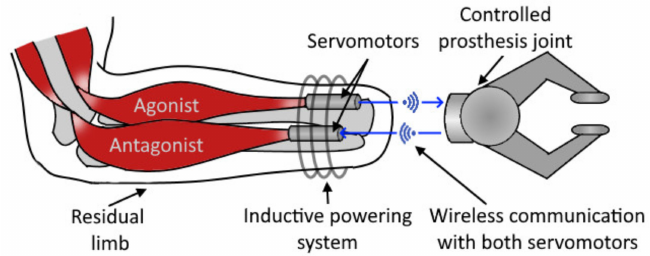
Figure 9. Illustration of the concept of Biomechatronic Extended Physiological Proprioception